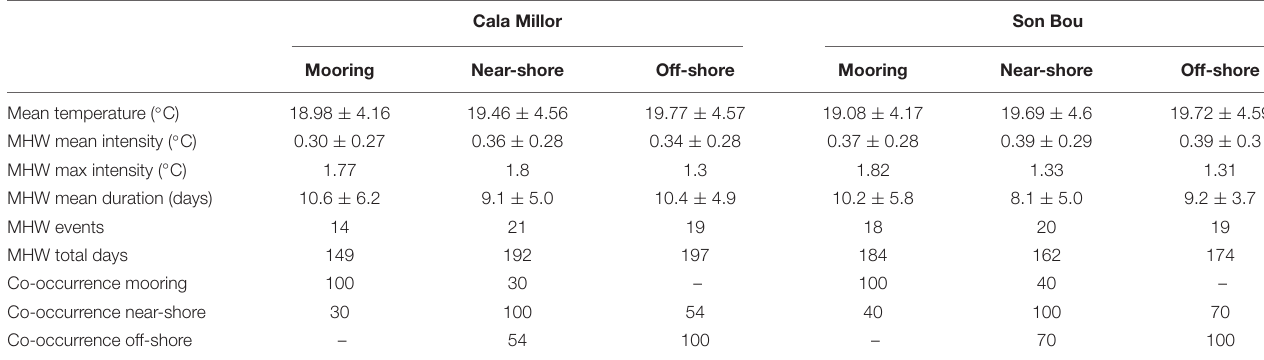
TABLE 4 | Statistics on temperature and detected MHWs from the mooring, near-shore and off-shore satellite points over the common monitored period from 2012 to 2020 for both sites of